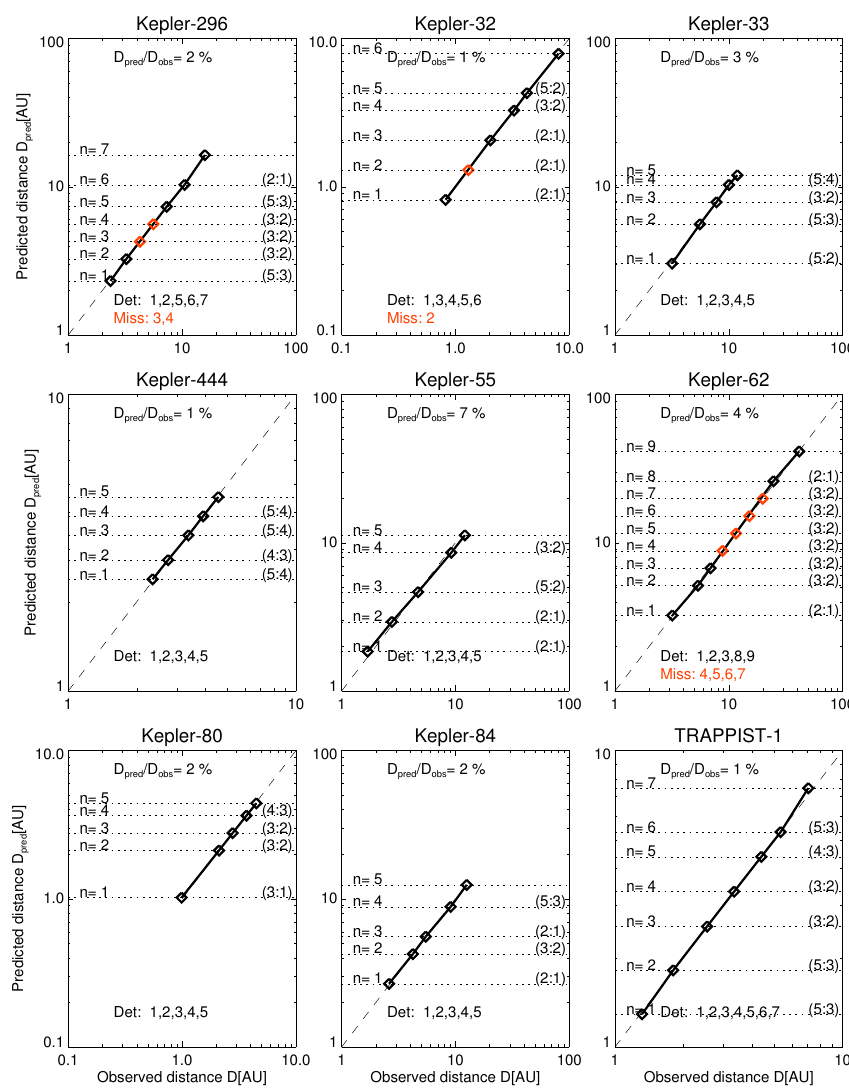
Figure 3. Exoplanets, with representation similar to Figure